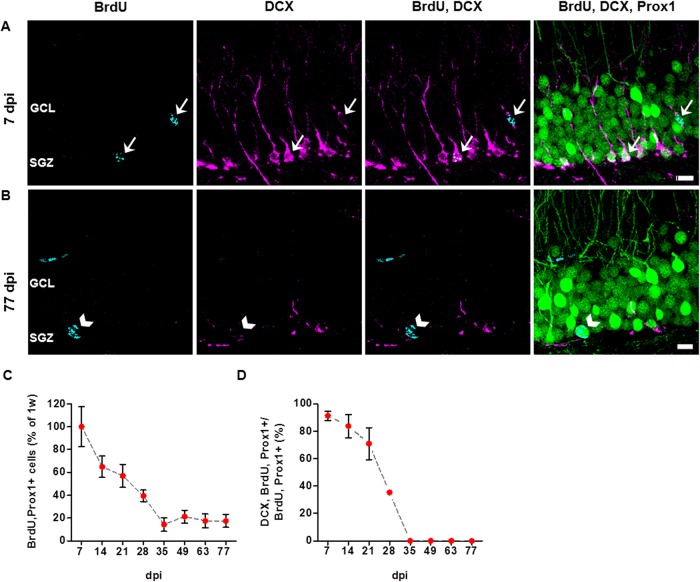
Survival rate of newborn dentate granule cells decreases over the first 4 weeks.(A, B) Newly born DGCs labeled with the mitosis marker BrdU (cyan) frequently displayed DCX-expression (magenta) at 7 days post BrdU injection (7 dpi; A), while there was no co-localization of BrdU and DCX at 77 dpi (B). All of the counted BrdU+ cells were Prox1+ (green; A, B). Arrows in (A) point to BrdU/DCX/Prox1+ cells. Arrowheads in (B) point to a BrdU/Thy1-GFP+ cell. Due to their intense somato-dendritic labeling, Thy1-GFP+ cells could be easily distinguished from the green nuclear Prox1 immunostaining. (C) Quantification of BrdU/Prox1+ cells revealed a decline in survival of newborn DGCs between 7 and 35 dpi, whereas the total number of BrdU+ cells did not change between 35 and 77 dpi. Compared to the first week post BrdU injection, 14% of BrdU/Prox1+ cells were retained at 35 dpi, after which there was no further cell loss. (D) The number of BrdU/Prox1+ DGCs that expressed DCX also decreased between 7 and 35 dpi. No DCX/BrdU/Prox1+ cells could be detected between 35 and 77 dpi. All analyses were performed in the suprapyramidal blade of the right dorsal dentate gyrus (n = 3 animals for each group, 3 sections per animal). Error bars represent SEM. Scale bars in (A, B): 10 μm. GCL, granule cell layer; SGZ, subgranular zone.